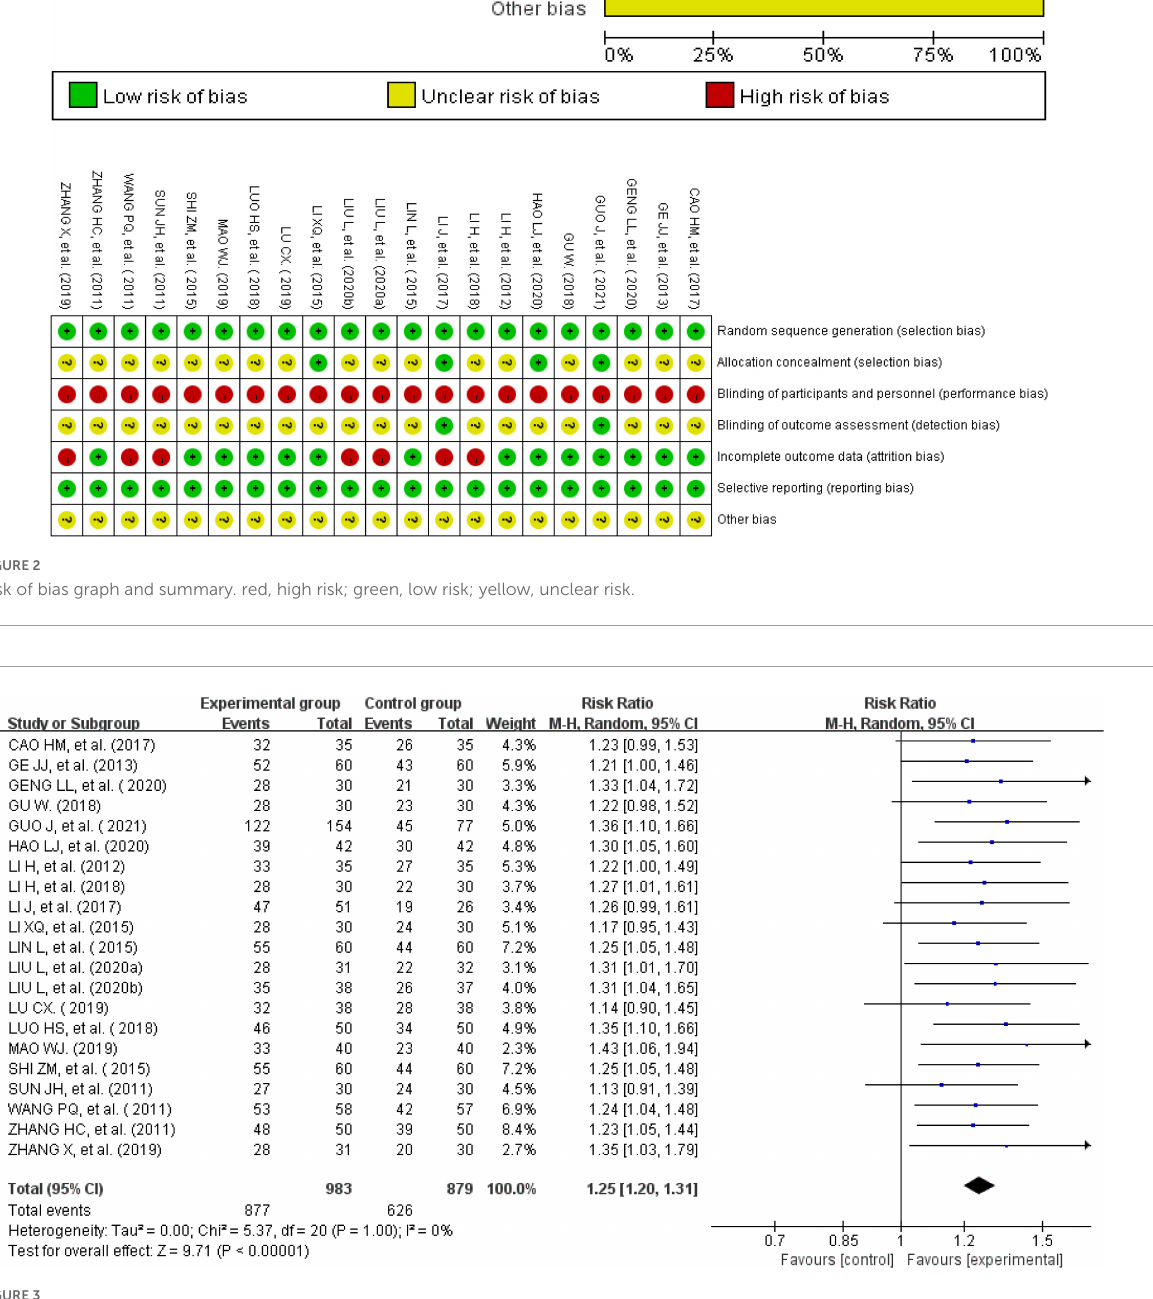
FIGURE3 Forest plot of the total effectiveness